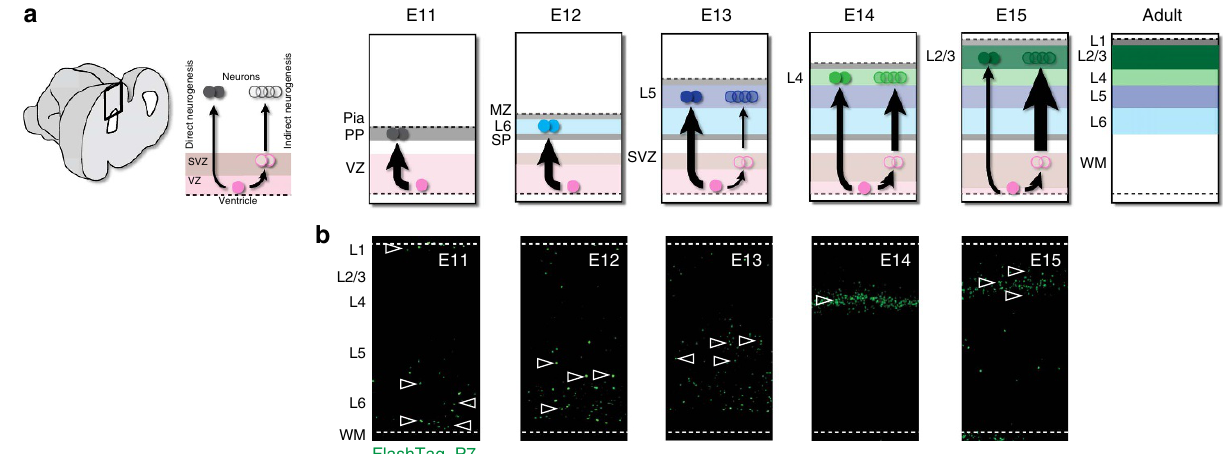
Figure 3 | Direct and indirect neurogenic pathways during corticogenesis. ( a ) The neocortex is built in an inside-out manner in which neurons born from deeply located germinal zone migrate past earlier-born neurons to reside in more superficial layers. Note that initially, the preplate (PP) is split into a subplate (SP) and superficially located marginal zone (MZ) by incoming L6 neurons, such that early born neurons are later found in L1. Direct neurogenesis from the ventricular zone (VZ) predominates at early developmental stages, while indirect neurogenesis from the subventricular zone (SVZ) progressively increases during corticogenesis. E: Embryonic day; MZ: marginal zone; PP: preplate; SP: subplate. ( b ) FlashTag (FT) labelling highlights neurons born in the VZ through direct neurogenesis (ref.